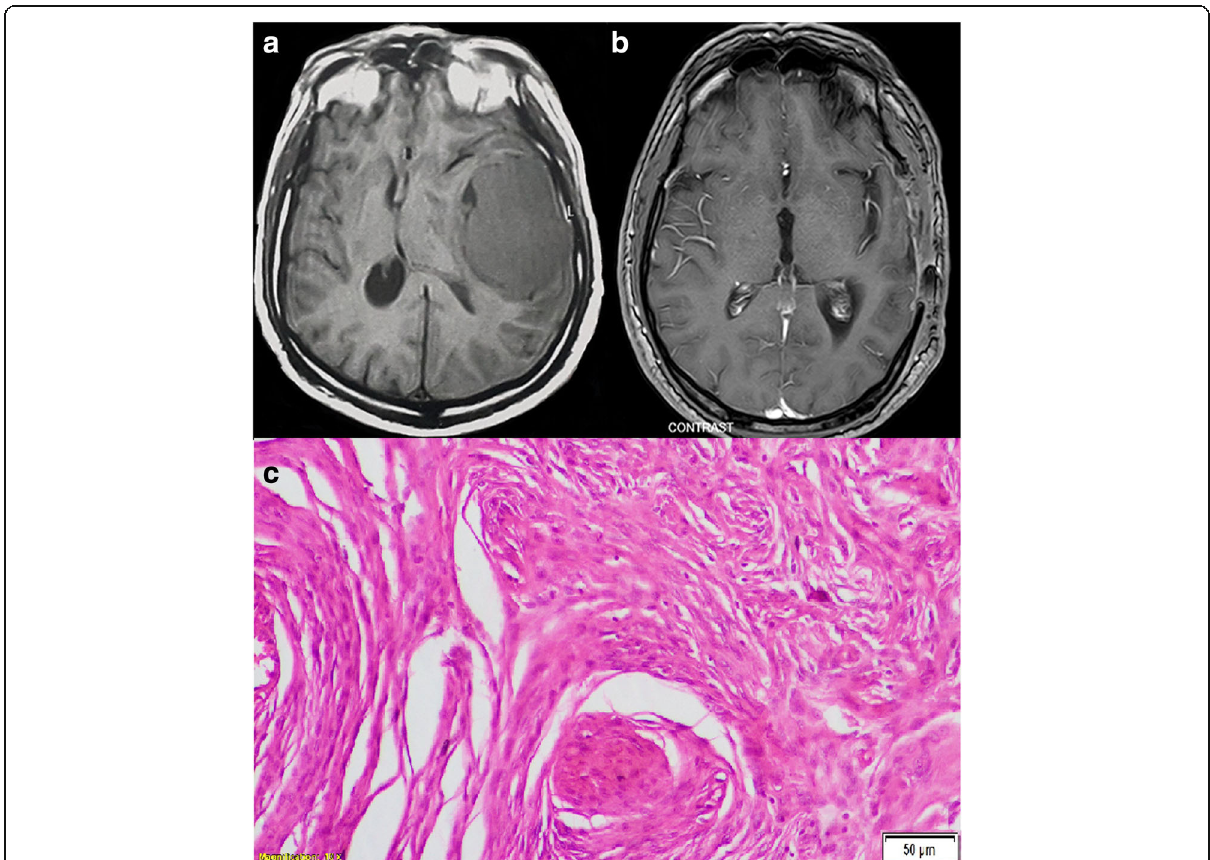
Fig. 3 A convexity meningioma. a Preoperative image, MRI without contrast (axial) verified mass lesion in the right temporal region. The tumor was surrounded by mild edema. b Two year postoperative MRI with contrast (axial) demonstrated complete removal of the mass. Geriatric Scoring System (GSS) score = 16. c The slide represented transitional meningioma, WHO grade